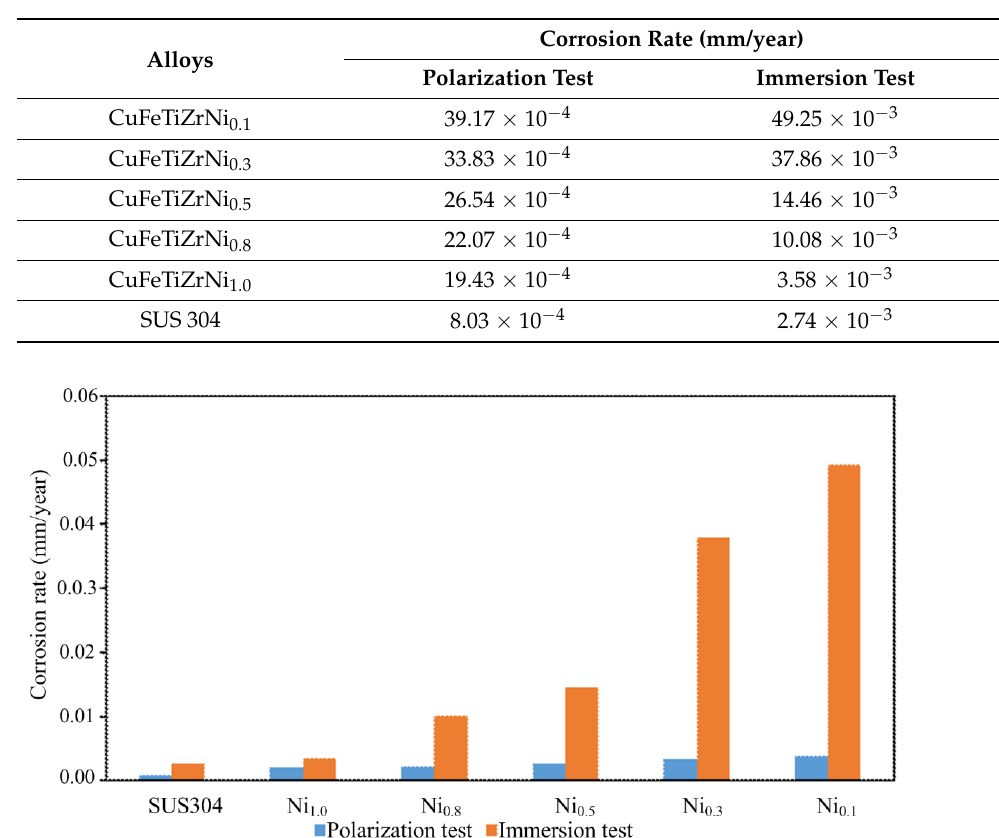
Figure 12. A comparison of the polarization and immersion test results of the CuFeTiZrNi x alloys and SUS 304. Table 5. The average corrosion rates (mm/year) of CuFeTiZrNi x alloys and SUS 304 in 3.5 wt.% NaCl solution.